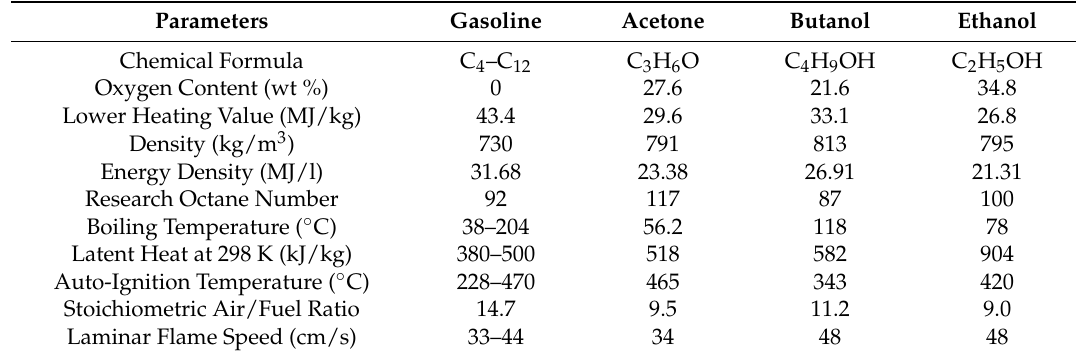
Table 1. Properties of the test fuels [15,36].